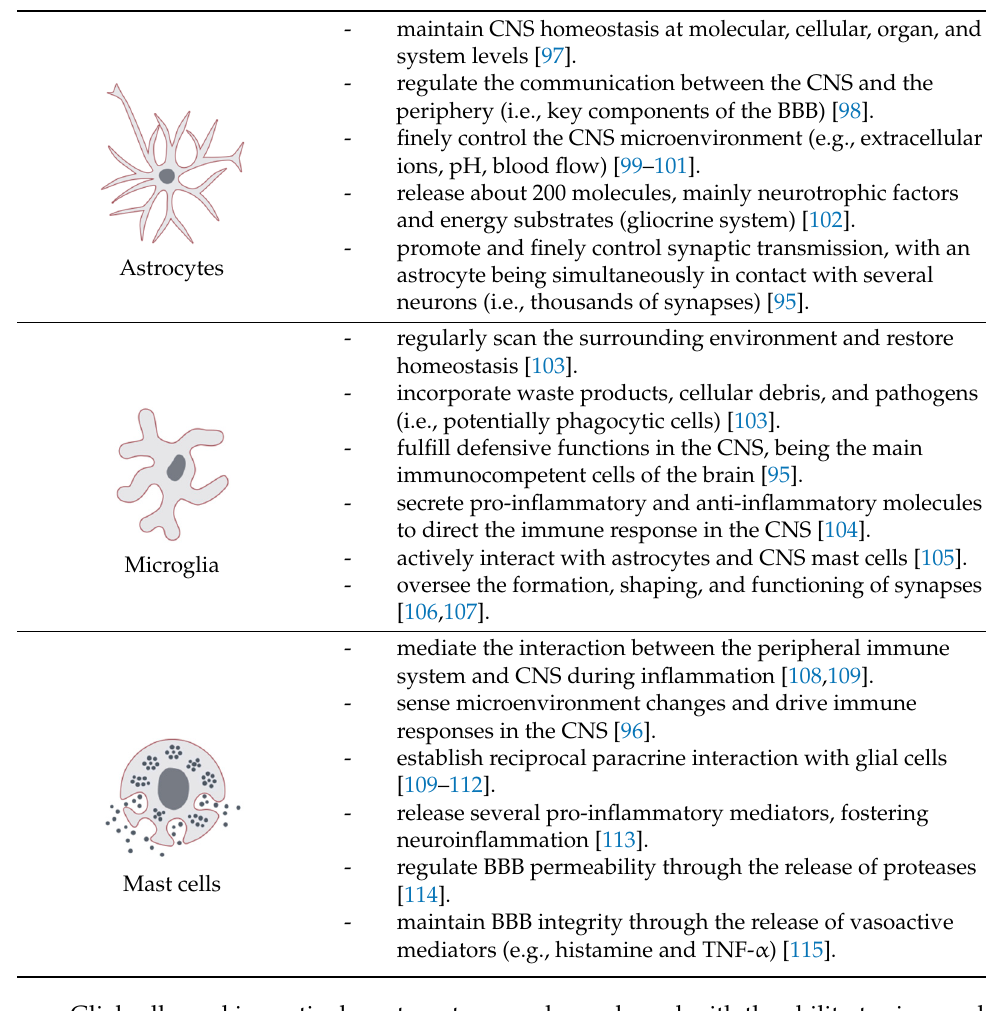
Table 2. Main functions of CNS glia and mast cells.